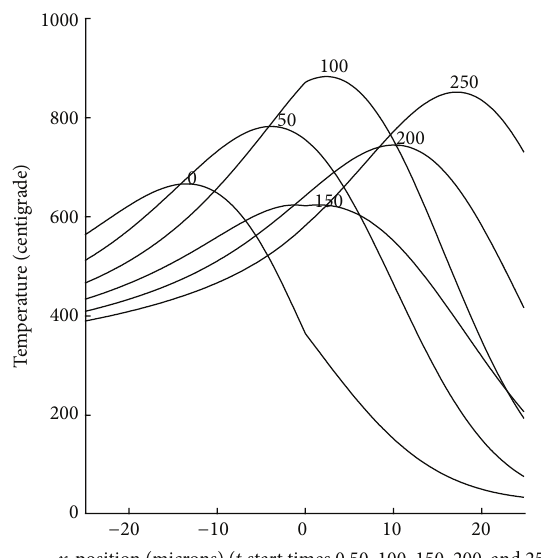
Figure 6: Temperature profiles on 𝑥 = 2.5 𝜇 m, 𝑦 = 0 , and V = 0.5 as a function of 𝑧 at times 0, 50, 100, 150, and 200 𝜇 s.